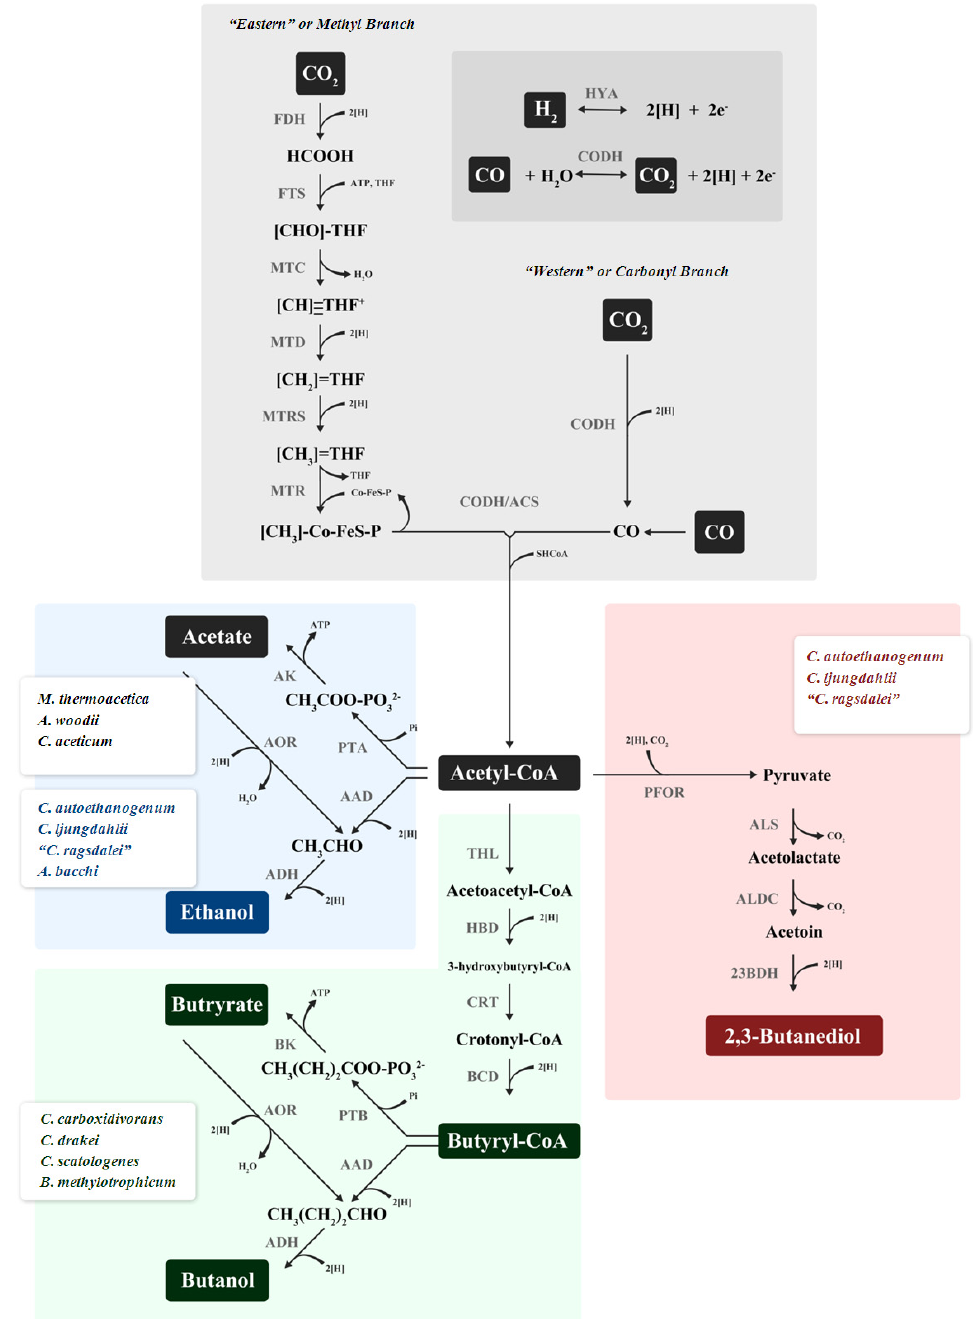
Figure 1. Wood-Ljungdahl pathway of acetogens and their metabolic end products [54,85,91–93]. Organisms are grouped according to their main interest for gas fermentation, but are able to produce more than one product, as outlined in Section 5 (for example C. carboxidivorans is able to produce acetate and ethanol in addition to butyrate and butanol). Single reactions shown do not represent stoichiometric